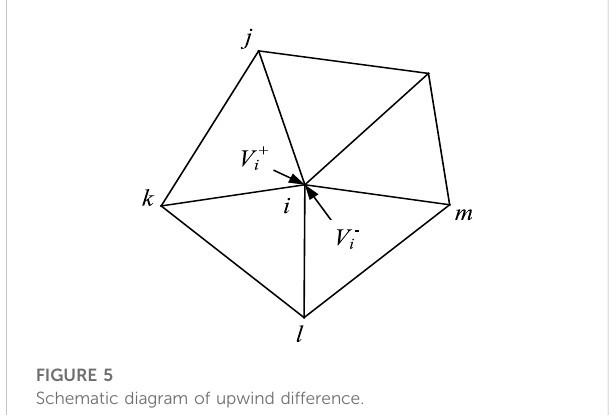
FIGURE 5 Schematic diagram of upwind difference.